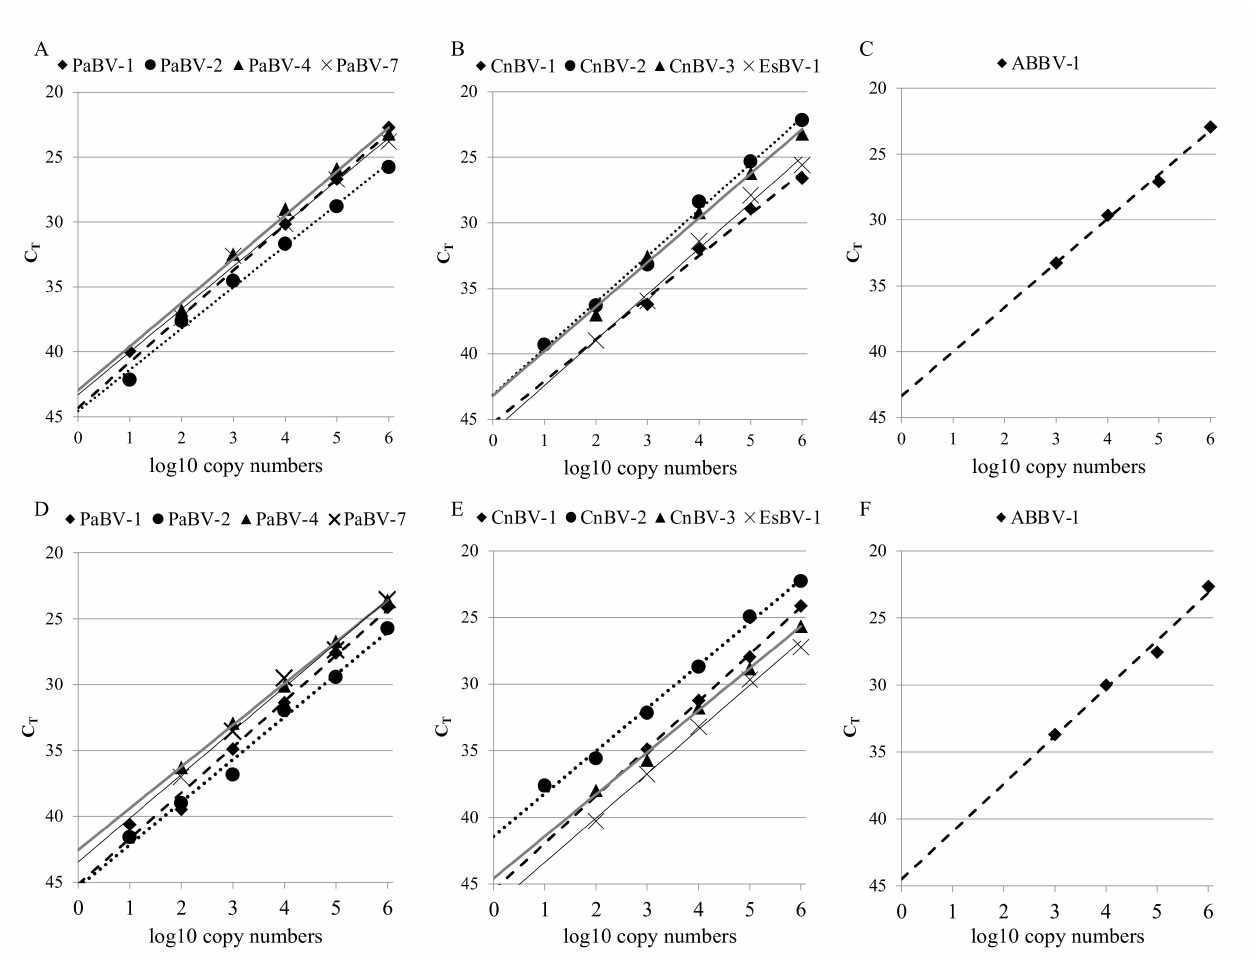
Figure 3. Analytical sensitivity of the rRT-PCR assay. Serial ten-fold dilutions of quantitated in vitro-transcribed reference RNAs of different avian bornaviruses were used as templates in a singleplex assay with the respective probe (( A ) Bor- naP_Fam; ( B ) BornaC_Aby; ( C ) BornaA_A647N) or in a multiplex assay where all three probes were used simultaneously ( D – F ). Results are presented as the mean C T values of two independent